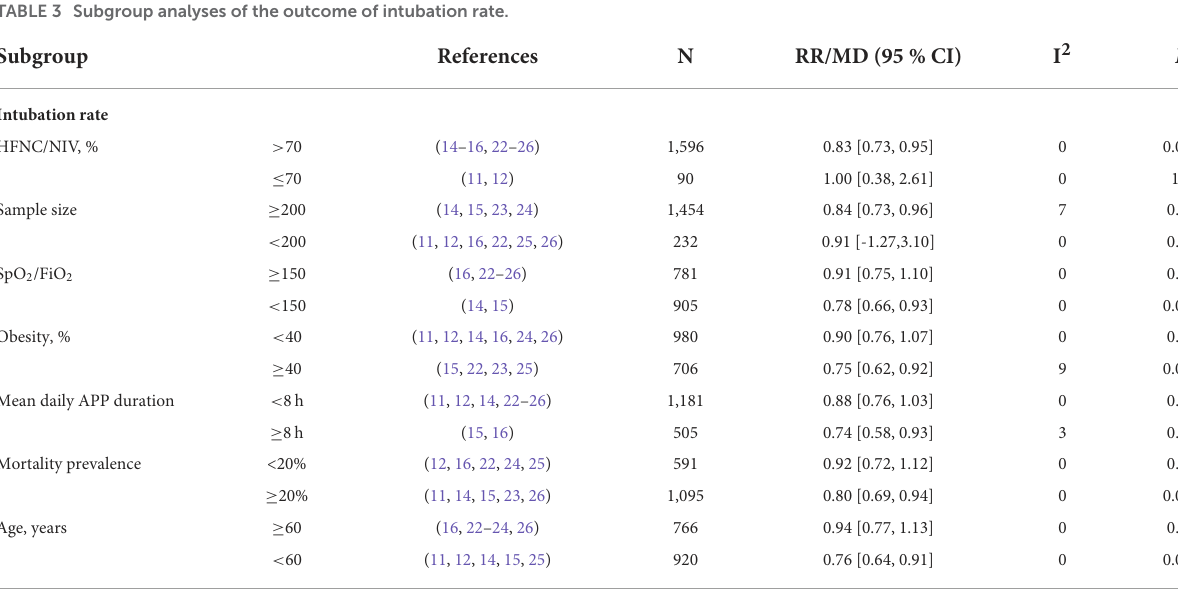
TABLE 3 Subgroup analyses of the outcome of intubation